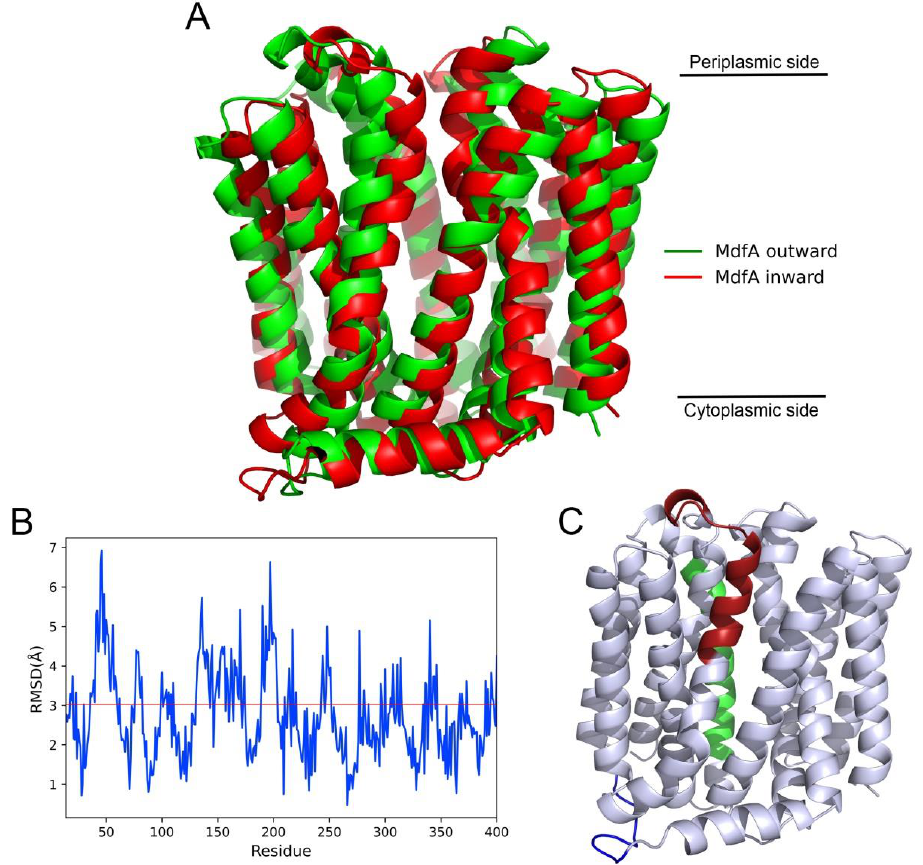
Figure 3. Alignment of MdfA inward1325 and MdfA outward74 revealed their subtle differences. ( A ): Alignment of superposed MdfA inward1325 and MdfA outward74 . ( B ): RMSD values of each residue between MdfA inward1325 and MdfA outward74 . Red line indicated the average RMSD between MdfA inward1325 and MdfA outward74 . ( C ): Visualization of the regions that had the highest RMSD. Red: Helix 1 (Residue 45 – 62); Green: Helix 5 (Residue 150 – 160); Blue: Hinge loop (Residue 195 – 200).